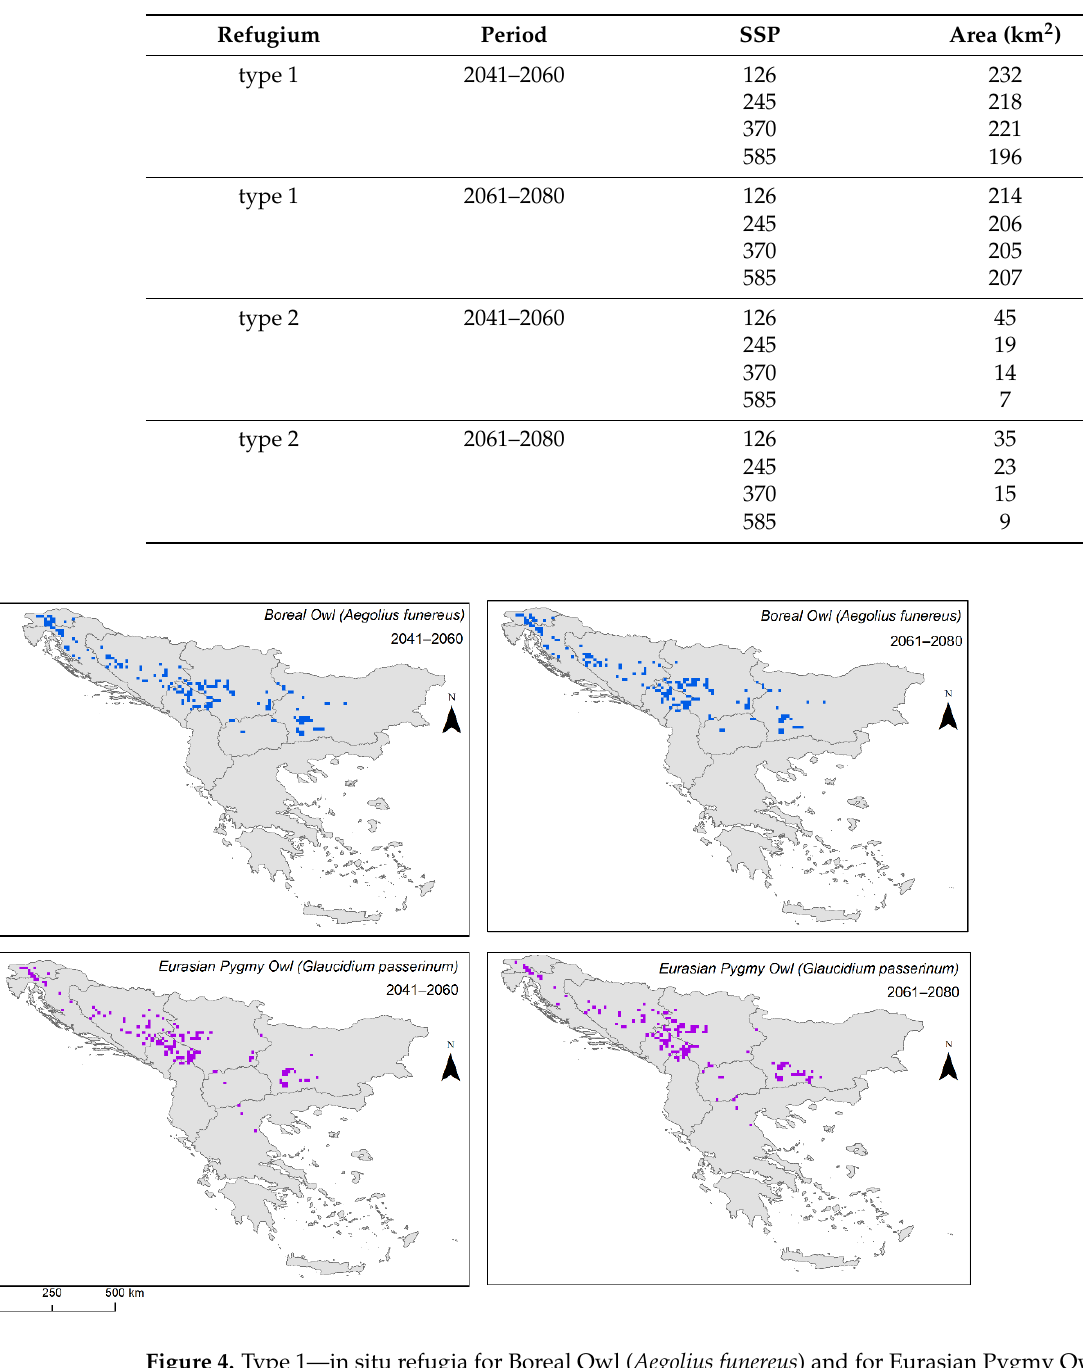
Figure 4. Type 1—in situ refugia for Boreal Owl ( Aegolius funereus ) and for Eurasian Pygmy Owl in the Balkan Peninsula in 2041–2060 and 2061–2080. Colour coding: grey = no refugia; blue = refugia for Boreal Owl; purple = refugia for Eurasian Pygmy Owl.